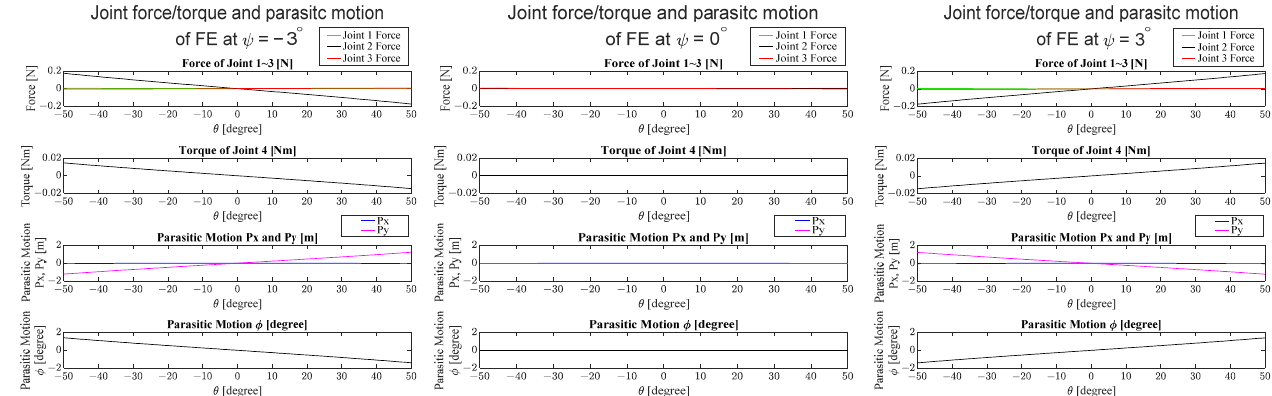
Figure 9. Relation between parasitic motions of the 3-RPS robot and the force/torque of the joints 1–4 for FE movement.